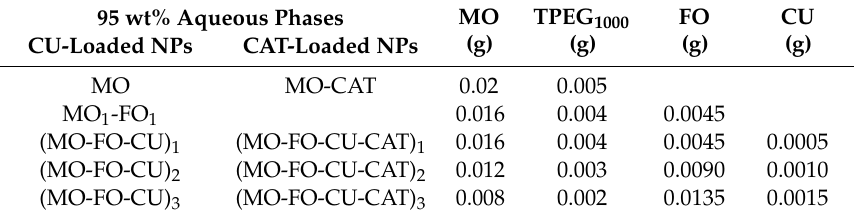
Table 4. Lipid nanoparticle constituents and their mass